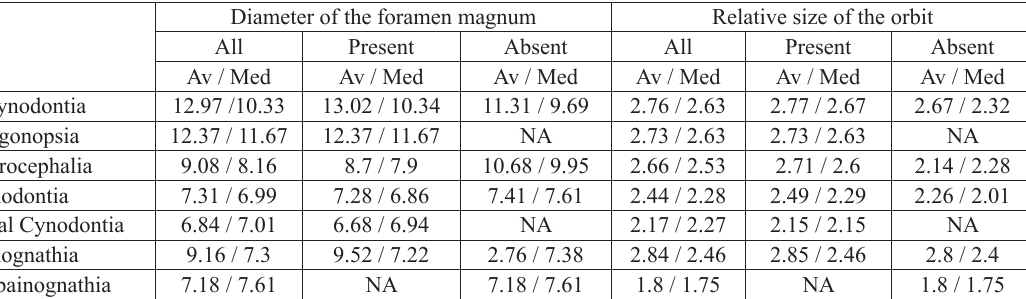
Table 1. Measurements (in mm) of the diameter of the foramen magnum and the relative size of the orbit in Therapsida. Average (Av) and median (Med) values are given for all representatives of a group (All), and for those with a parietal foramen (Present) and without (Absent). NA, no data available.